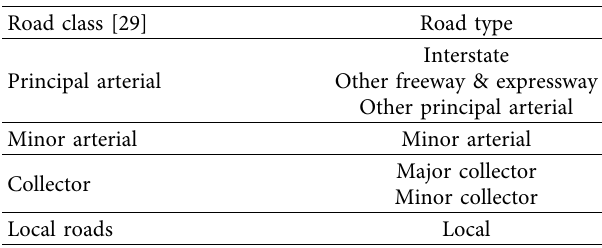
Table 2: Road classes and